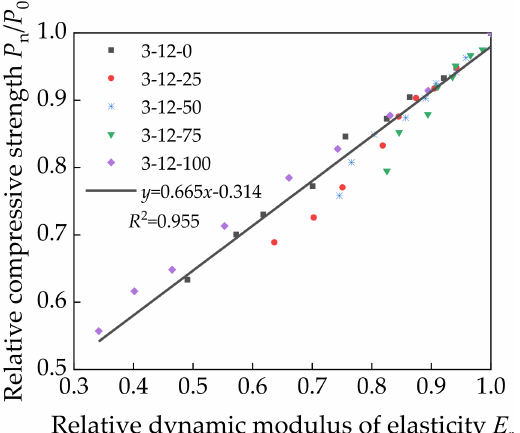
Figure 12. Relationship between the relative dynamic modulus of elasticity and relative compres- sive